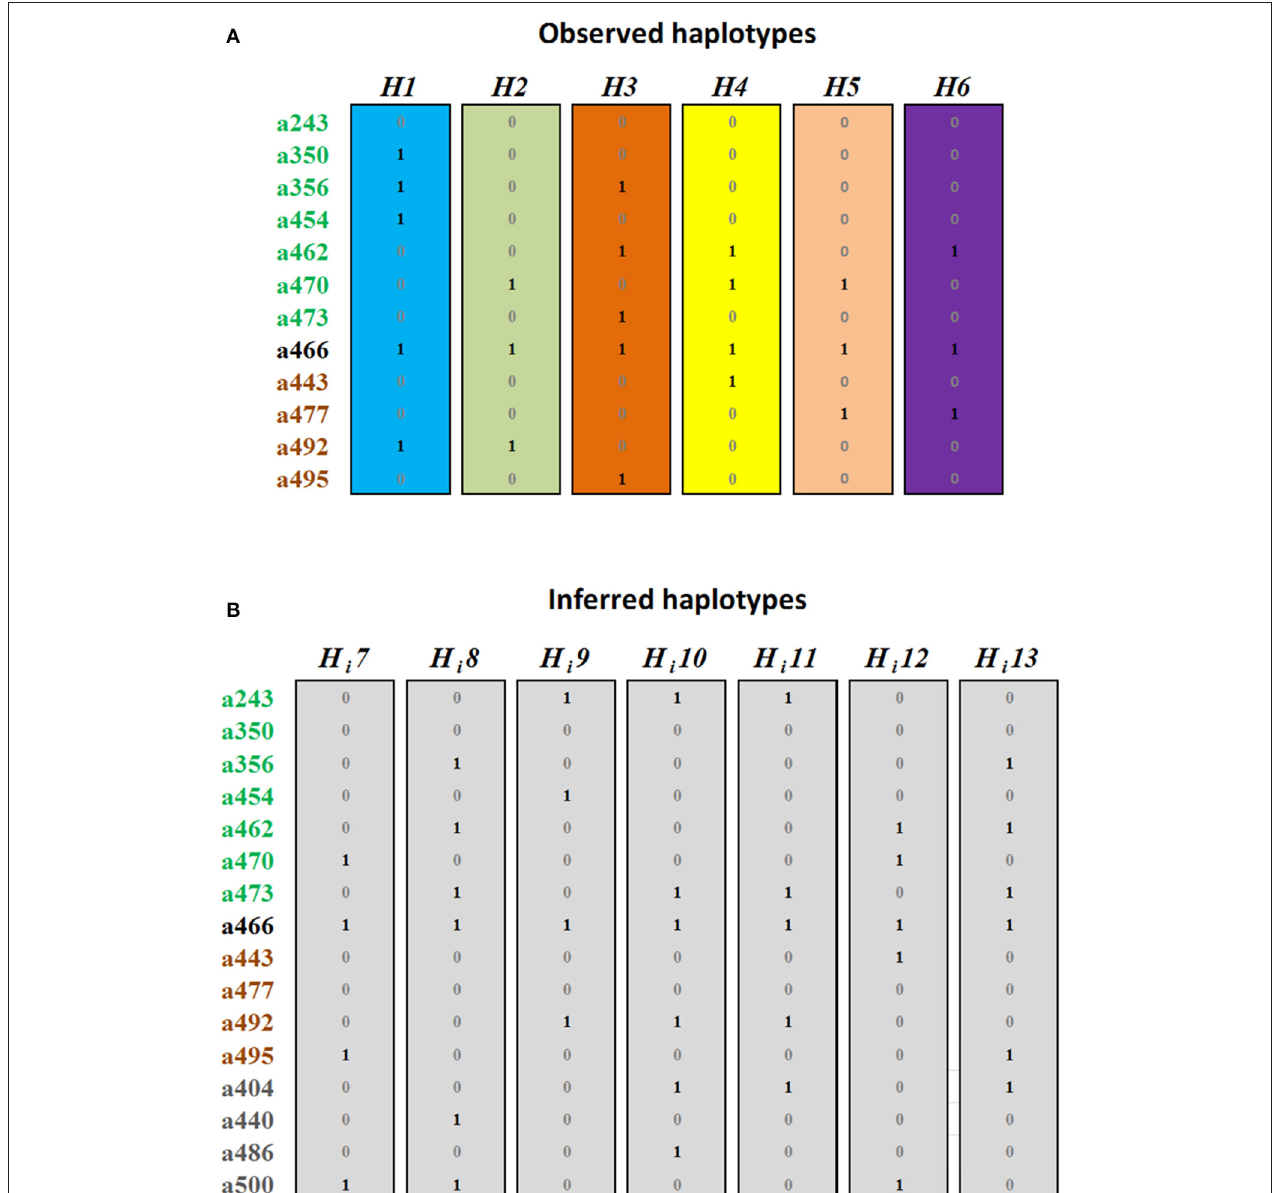
FIGURE 3 | Haplotypes with (1) or without (0) each MYB10 allele, grouped and colored according to their homology with PpMYB10.1 , PpMYB10.2 , and PpMYB10.3 . (A) Haplotypes identified in six F1 progenies. (B) Haplotypes inferred from the collections of advanced breeding lines (ABL) (H i 7–H i 12) and commercial varieties (CV) (H i 12, H i